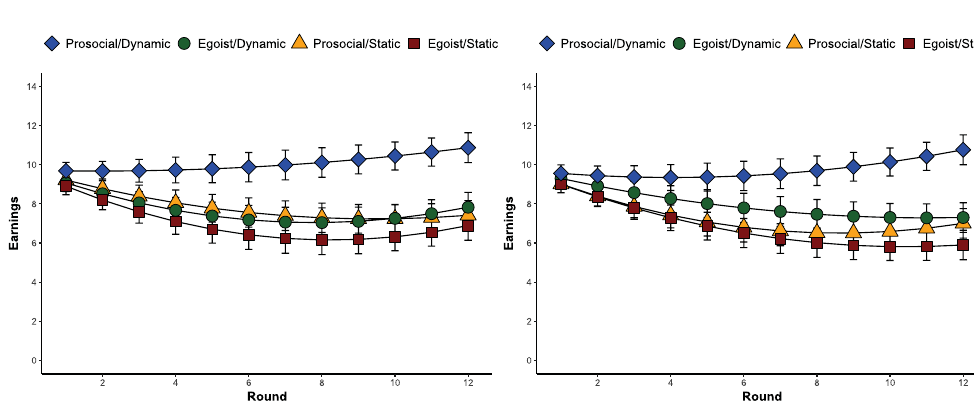
Figure 3. Marginal earnings/fitness in ( A ) homogeneous and ( B ) heterogeneous networks. Error bars refer to 95% confidence intervals around the marginal